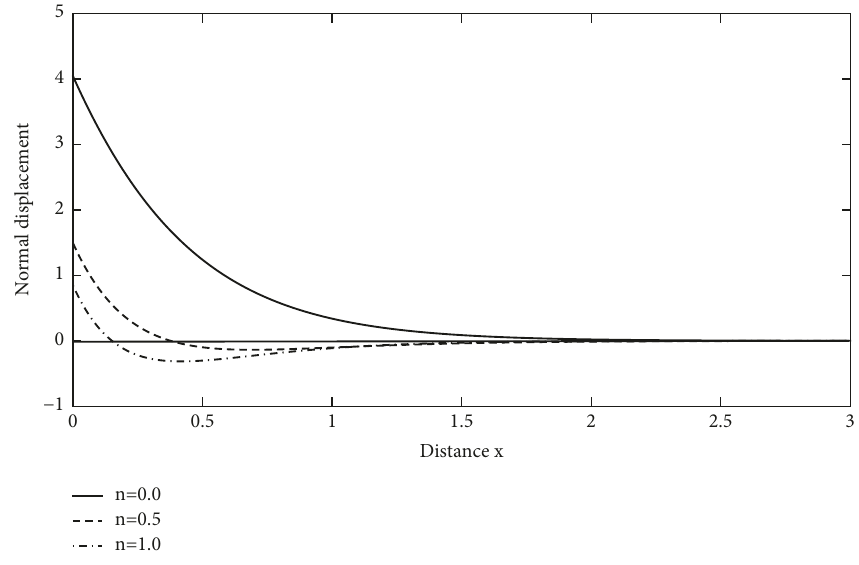
Figure 6: Effect of nonhomogeneity parameter on normal displacement distribution.